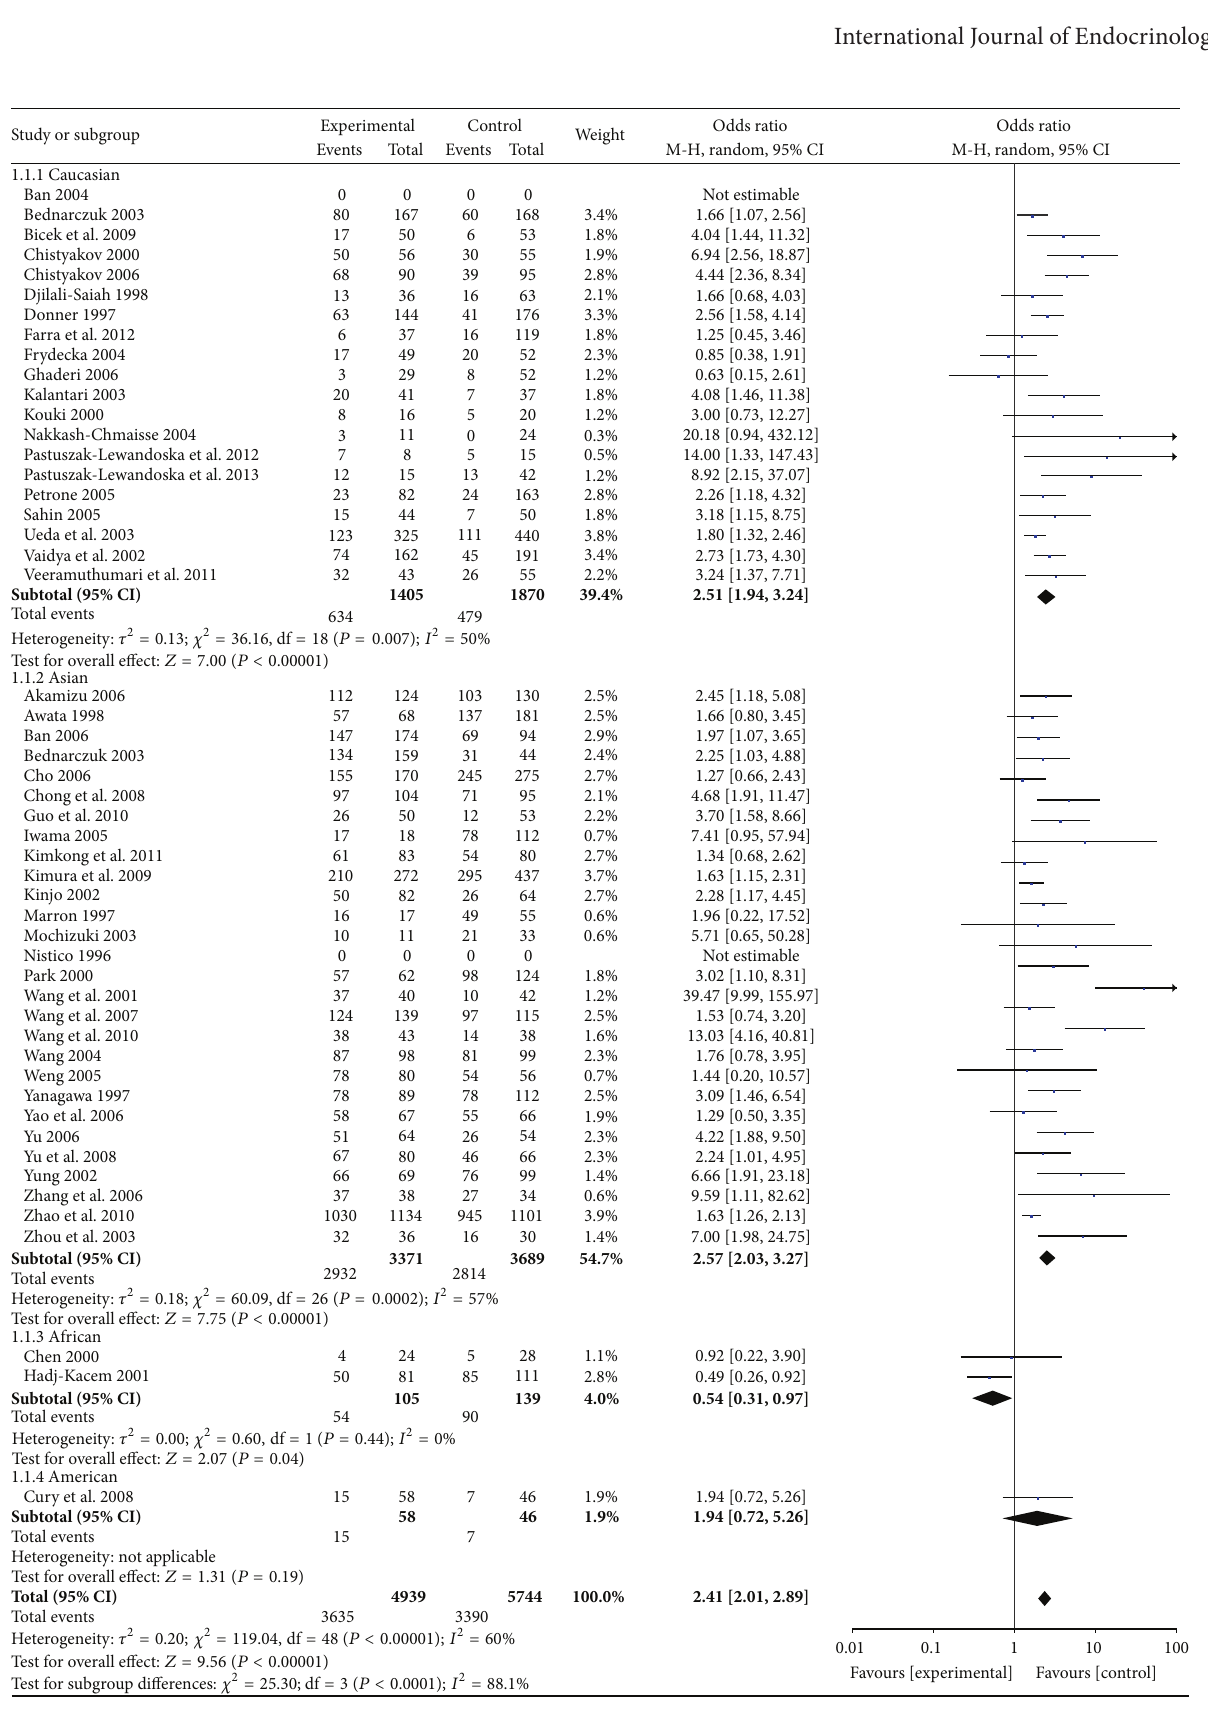
Figure 2: Forest plot of the association between an additive model of A49G polymorphism and